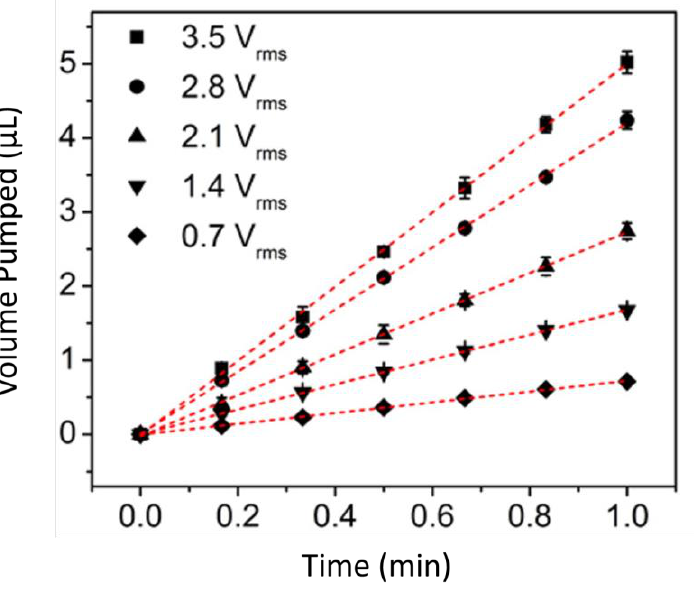
Figure 8. Volume pumped vs. time as the indicated values of V rms at a frequency of 20 Hz. Reprinted and adapted with permission from [11]. Copyright 2016, American Chemical Society.